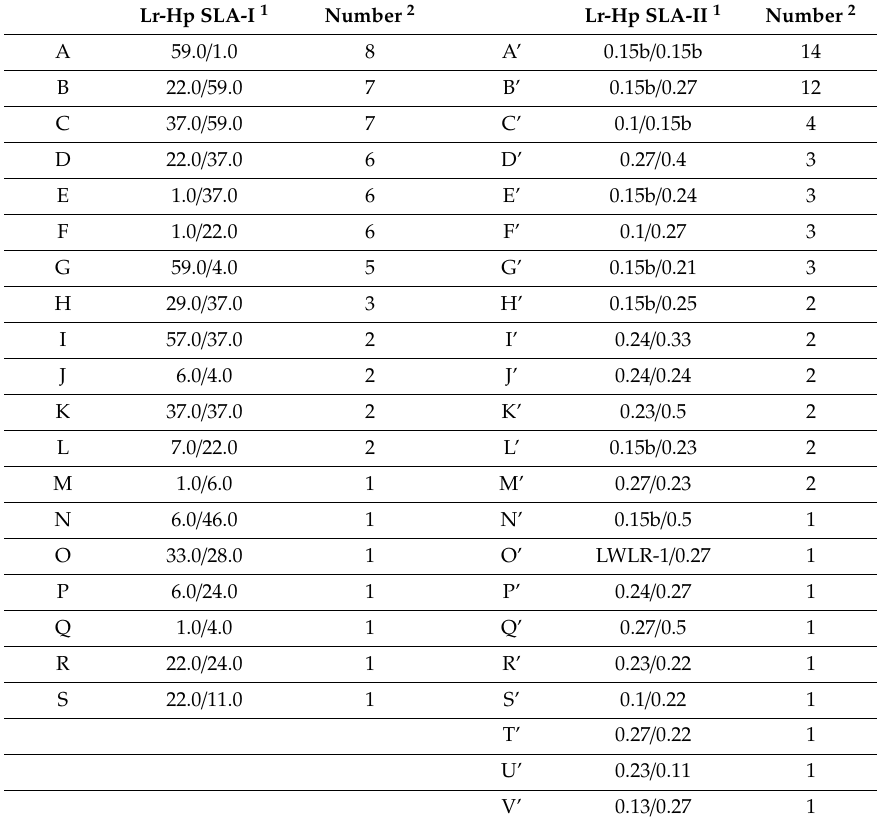
Table 3. SLA-I and SLA-II Low-resolution Haplotype notation and